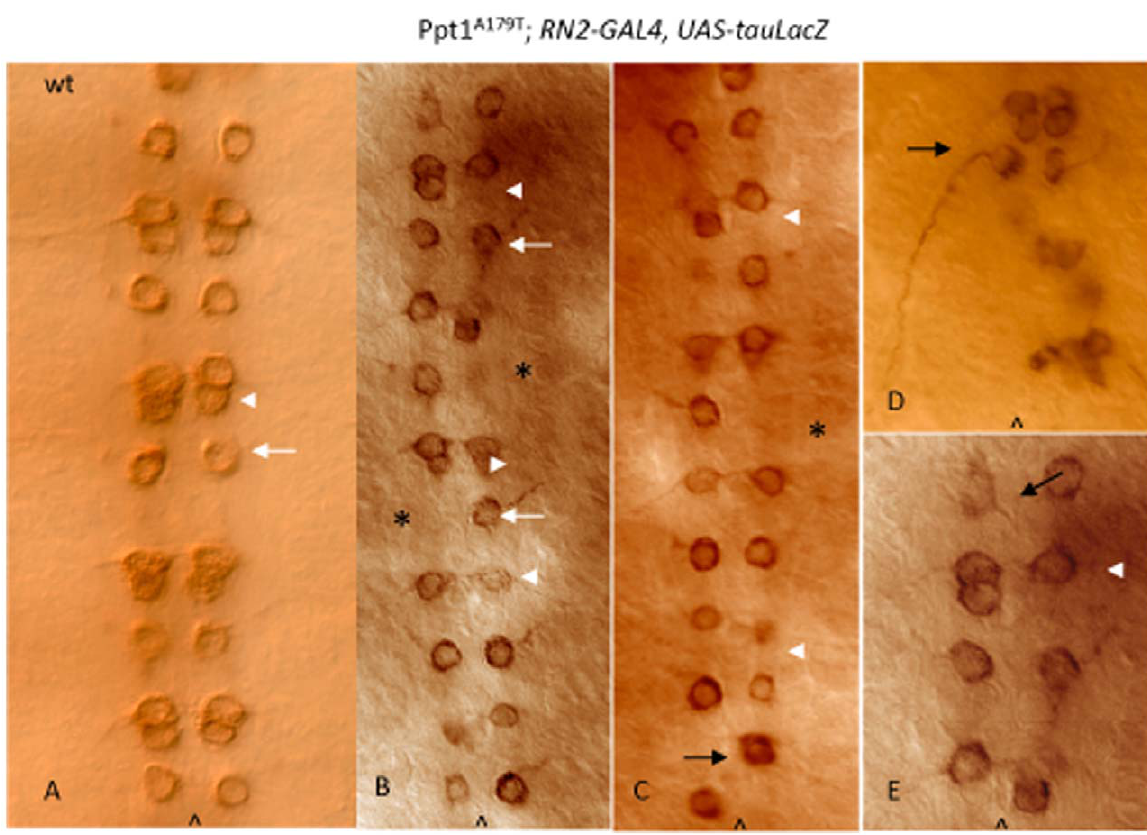
Figure 3. Ppt1 mutants exhibit abnormal RP2 axon trajectories. S16 ventral nerve cord stained with anti- b -gal to detect RN2- tau-lacZ expressed in aCC, pCC and RP2 neurons. (A) Wild type RN2- tau-lacZ pattern showing RP2 neuron and its axon trajectory (white arrow); and aCC/pCC neurons (arrowhead). (B–D). Ppt1 A179T ; RN2-Gal4:UAS- tauLacZ embryos display a loss of RP2 motoneurons (asterisks) and aCC/pCC neurons (arrowheads) in many hemisegments; and disorganized cellular arrangements of the remaining LacZ-positive neurons. Many hemisegments have normal RP2 axon trajectory (white arrow) while others do not (black arrow). The RP2 in panel C shows an abnormal axon trajectory projecting posteriorly instead of anteriorly. Panel E is an enlarged subset of B. Anterior, up; caret, midline.